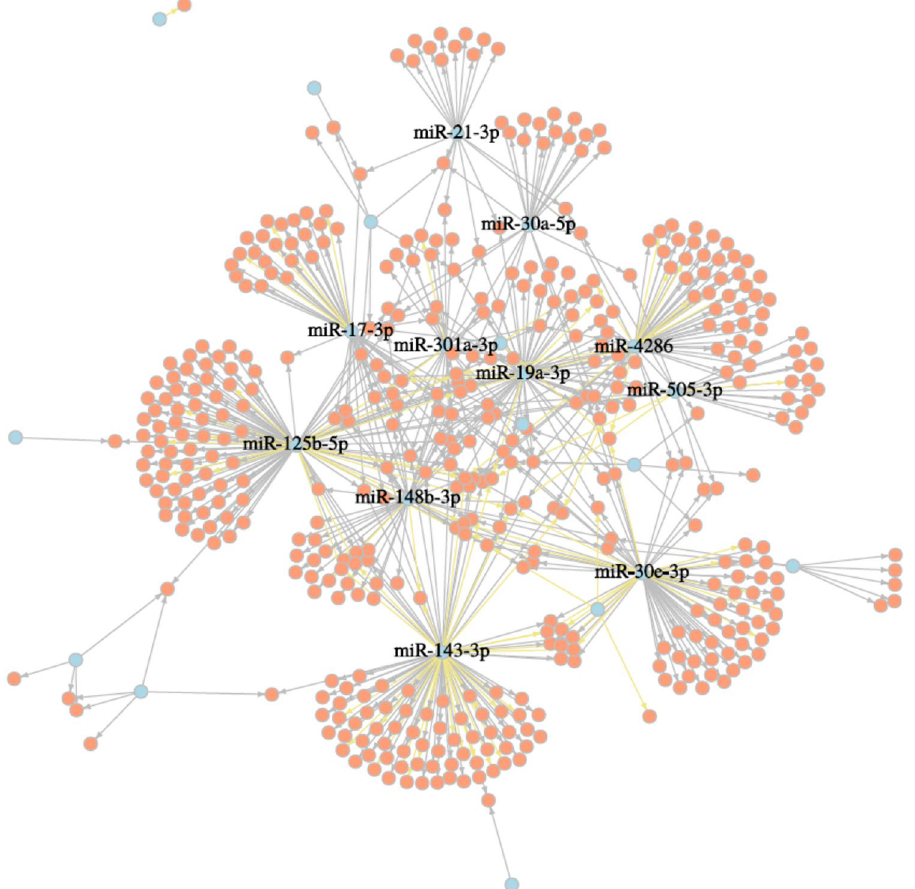
Figure 6. Correlation network of miRNAs that were differentially expressed in CAD patients compared to the controls in the classical monocyte subset. Illustrated are just pairs, that correlated more than ± 0.85 (Pearson’s r) and miRNAs having more than 10 targets. Negative correlations are highlighted in yellow, miRNAs in blue and targets in